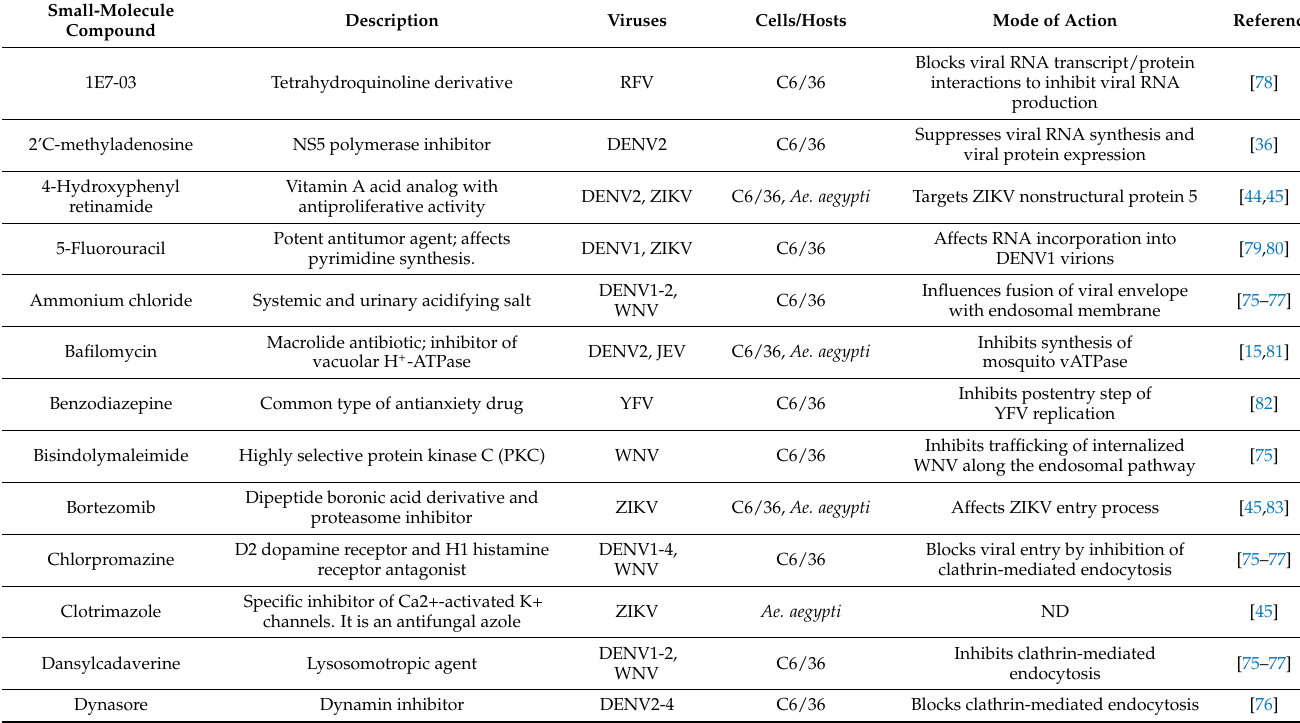
Table 2. Small-molecule compounds with anti-arboviral activity in mosquitoes and mosquito